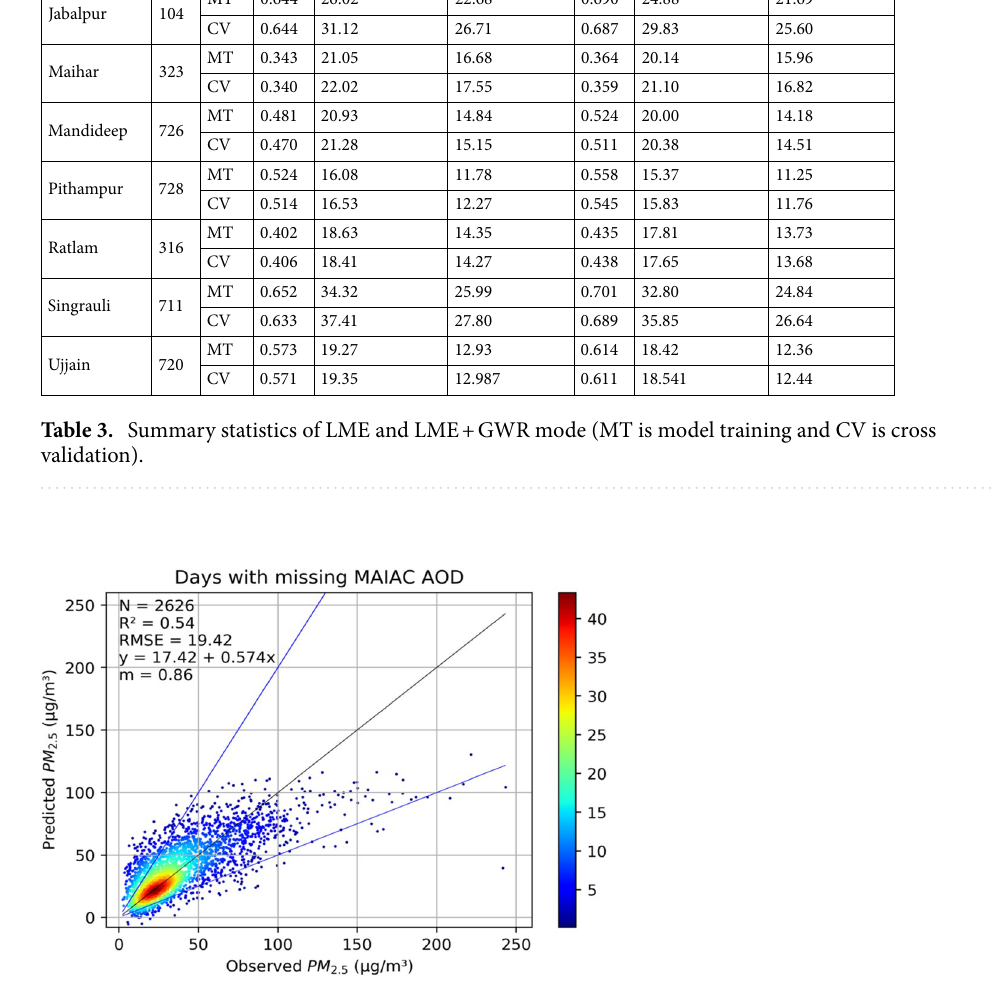
Figure 3. Comparison between the final model predicted PM 2.5 using tenfold cross-validation and surface concentration on days where MAIAC AOD was unavailable. c-axis shows the point count and the blue lines are y = 2 × and y = x/2 while the black is x = y line. “m” is the slope if the regression is forced through